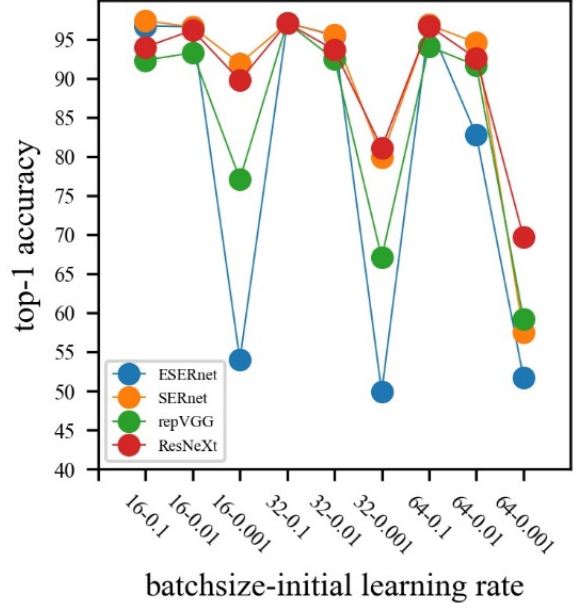
Figure 7. K-fold cross-validation results of different models. Table 1. The Optimal Parameter Combination of Different Models.